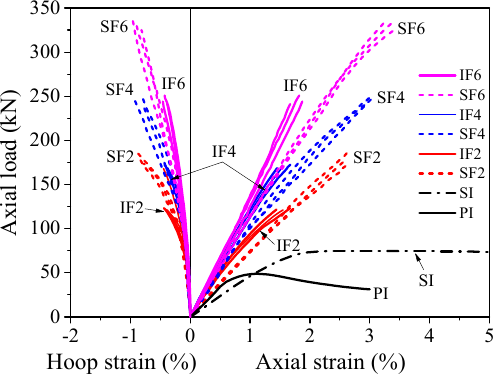
Figure 9. Axial load vs. strain responses of PIFFT and SIFFT specimens.